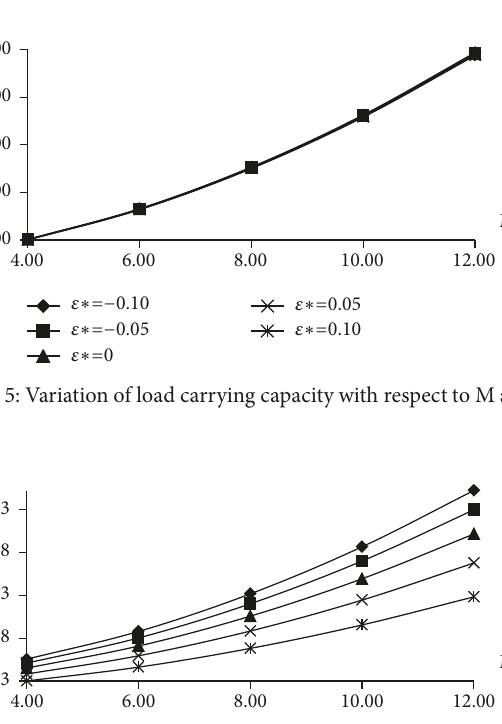
Figure 4: Profile of load with respect to M and 𝛼 ∗ .